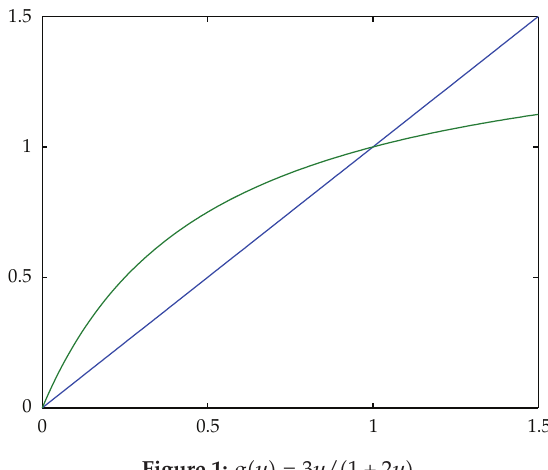
Figure 1: g (cid:6) u (cid:7) (cid:8) 3 u/ (cid:6) 1 (cid:5) 2 u (cid:7)